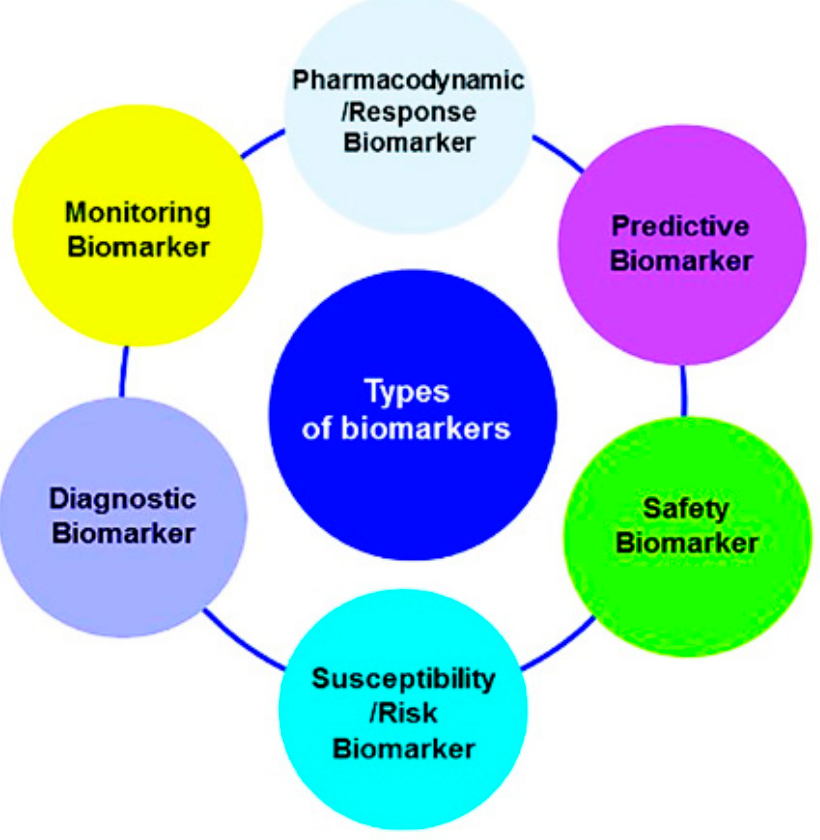
Figure 1. Classification of biomarkers according to their clinical applications. Reprinted from [3].